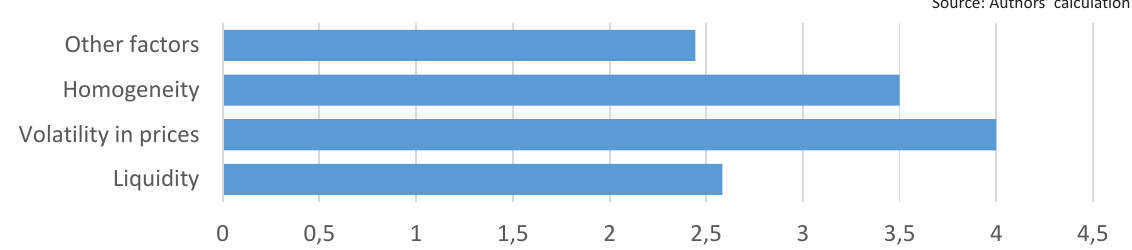
Figure 4. Experts’ evaluations on the feasibility of introducing coffee futures into the domestic commodity